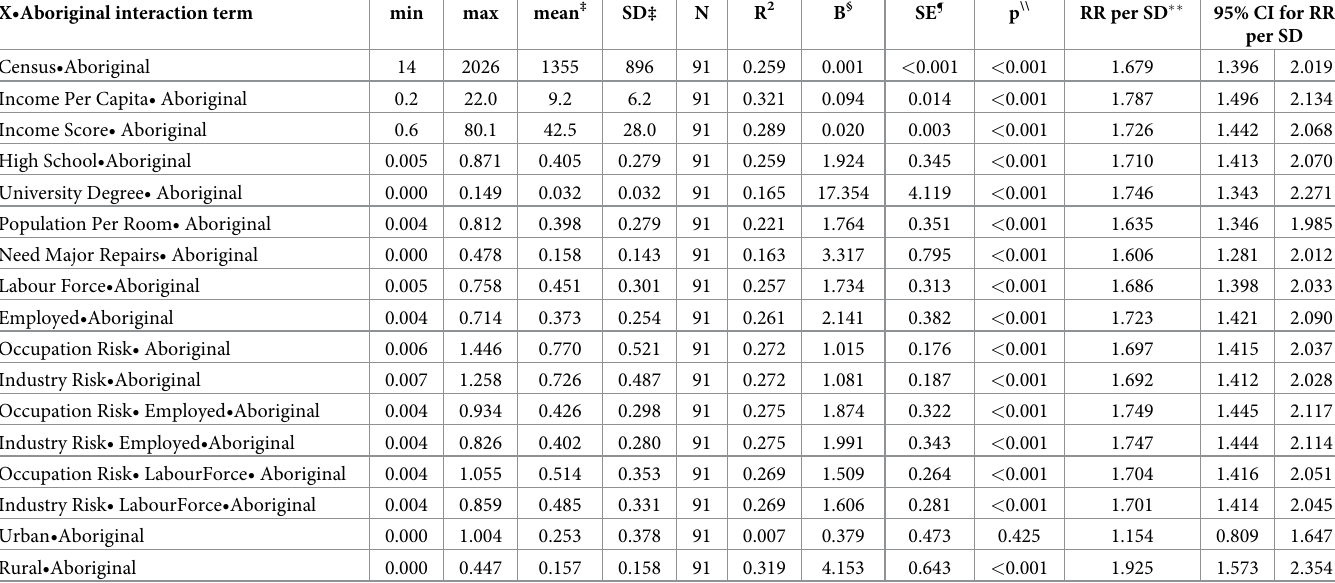
Table 7. Ecologic analysis (cid:3) of risk of hospitalization due to unintentional transport injury among Health Service Delivery Area Population Groups in British Columbia, 1999–2008†.